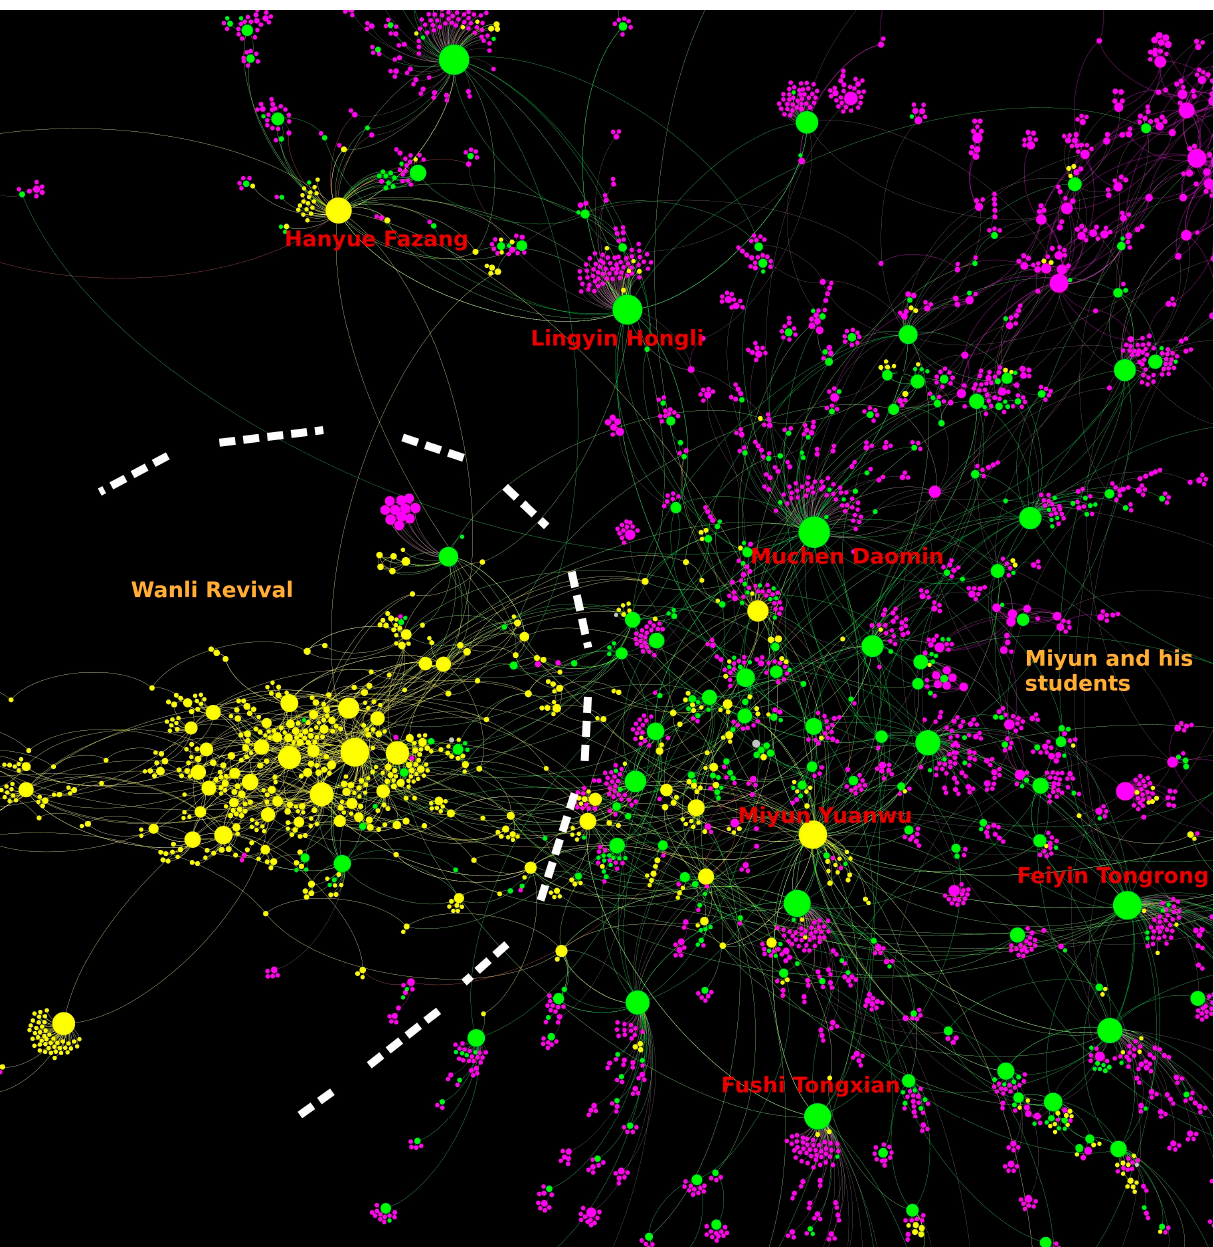
Figure 3. Two stages in the late Ming revival: the Wanli revival and Miyun’s lineage. Yellow nodes: actors born and died in the Ming. Green nodes: born in the Ming and died in the Qing. Magenta nodes: born and died in the Qing.